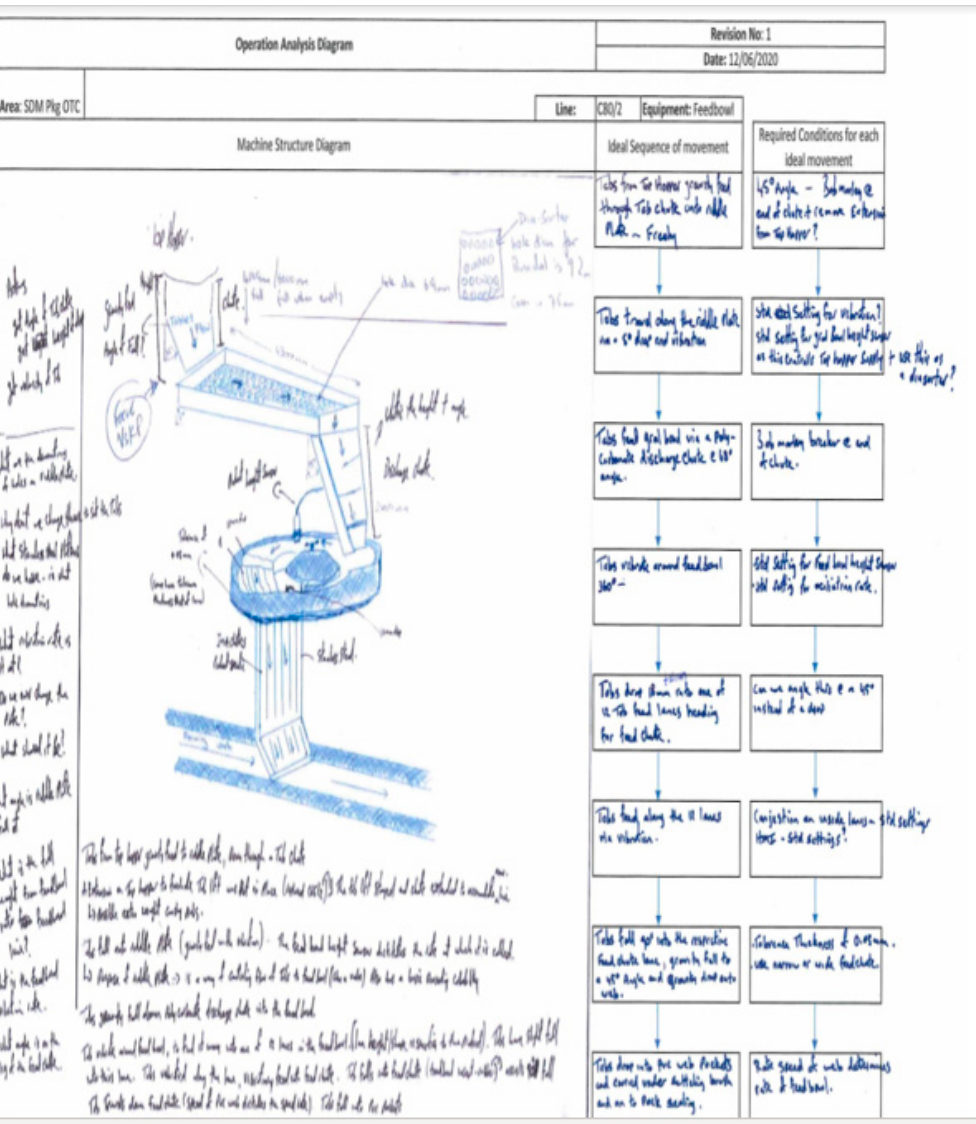
Figure 16. Principal of Operation (POA) of the Feed Hopper analysis led to understanding of a series of steps which contributed to the line stops.